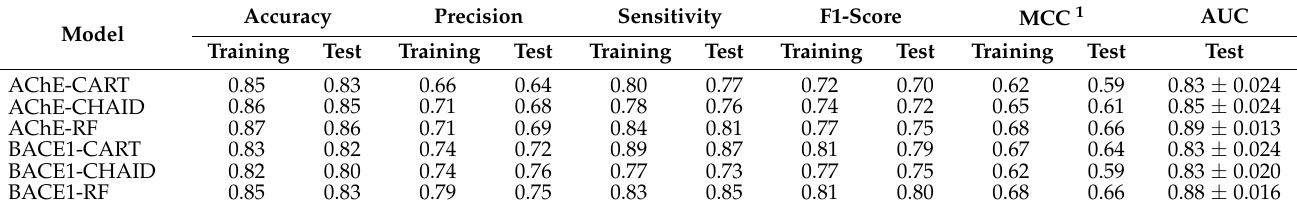
Table 1. Overview of the performance parameters of the six machine learning models.